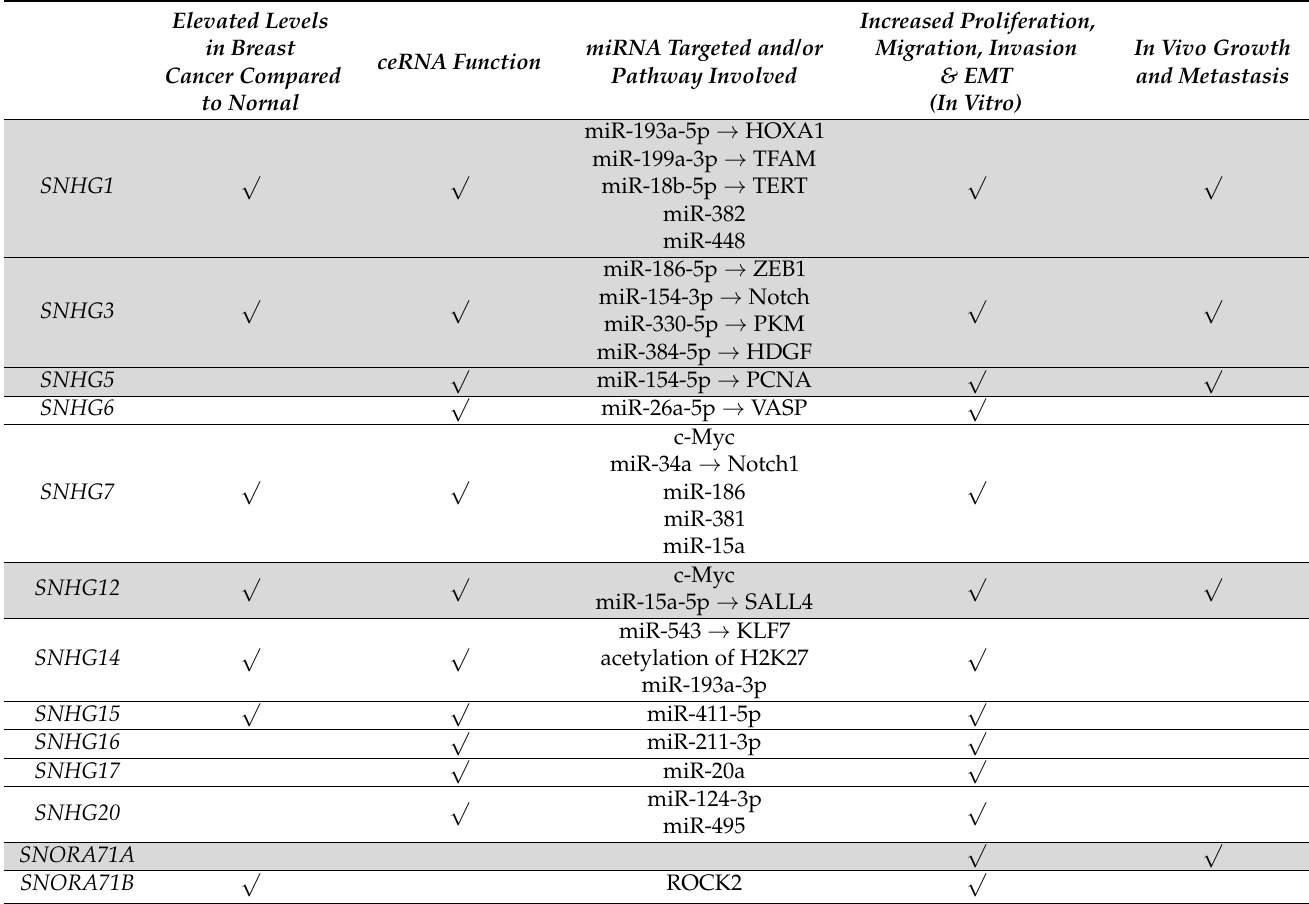
Table 2. Summary of studies performed on the function of different snoRNAs in breast cancer metastasis using both in vitro and in vivo approaches. Gray rows show the snoRNAs that were studied both in vitro and in vivo while white rows show the snoRNAs that were studied in vitro